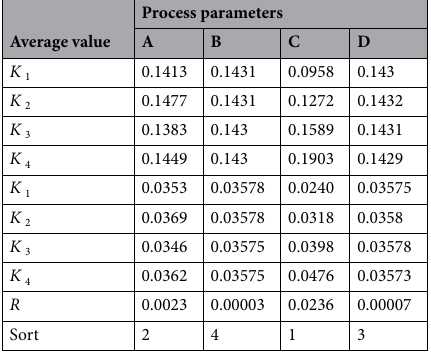
Table 7. Mean values of each parameter on warpage deformation.